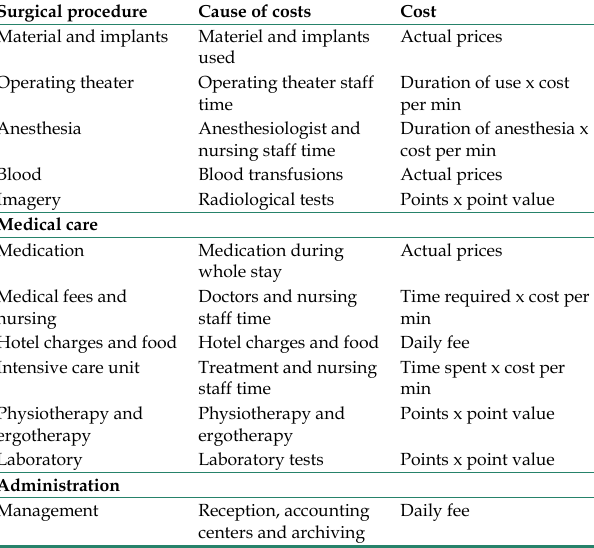
Table 2. Type of resources used.